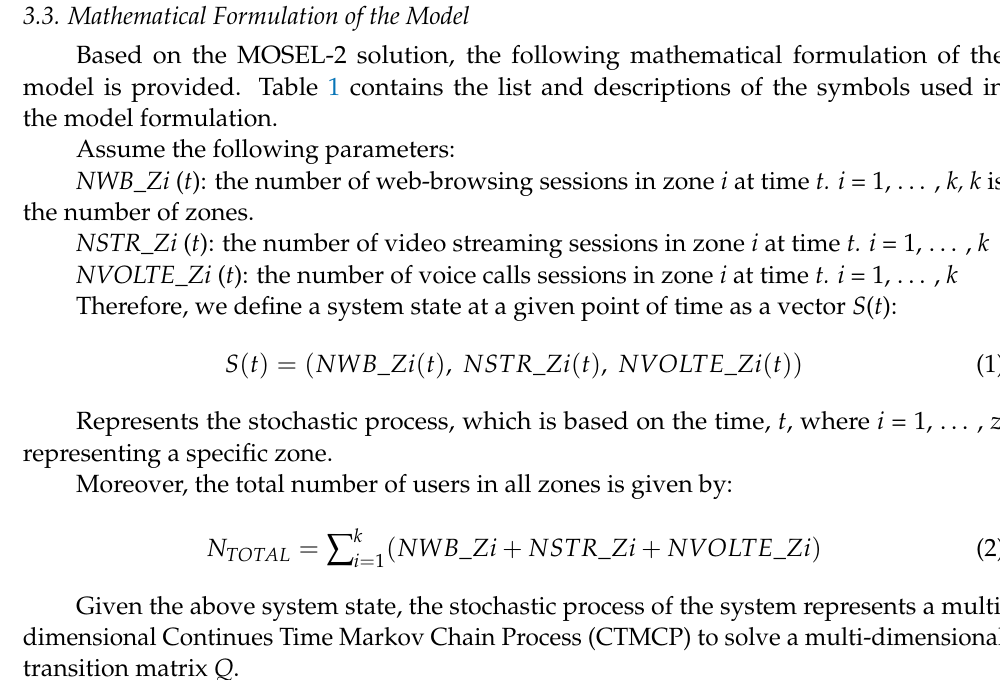
Table 1. Symbols used in the mathematical formulation of the model.